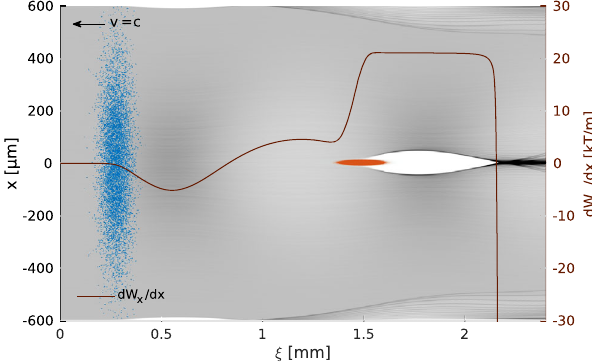
FIG. 2. QuickPIC simulation results showing the initial time step for the single proton drive beam and witness beam setup. Plasma electron density is shown in grey with the drive beam (blue) and the witness beam (red) superimposed. The line plot indicates the transverse wakefield gradient d W x = d x where W ¼ E − v B x x b y , evaluated along the beam axis. Beams move to the left.